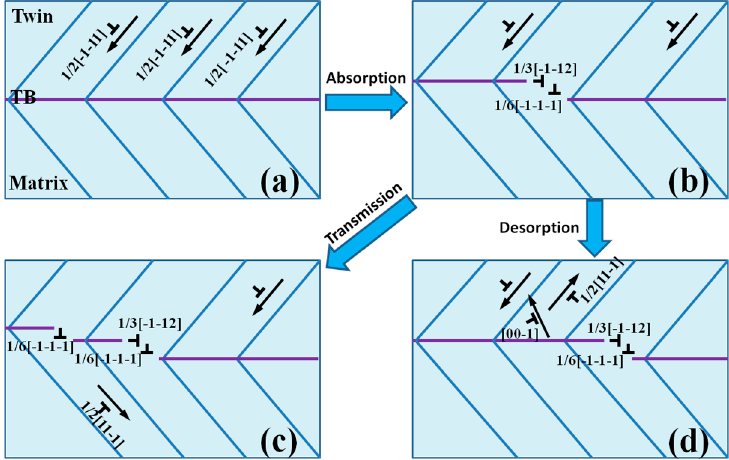
Figure 5. Schematic illustration for interaction between dislocation and CTB. ( a ) a set of incident <111> full dislocations, ( b ) dislocations absorption, ( c ) direct slip transmission, and ( d ) dislocations desorption.